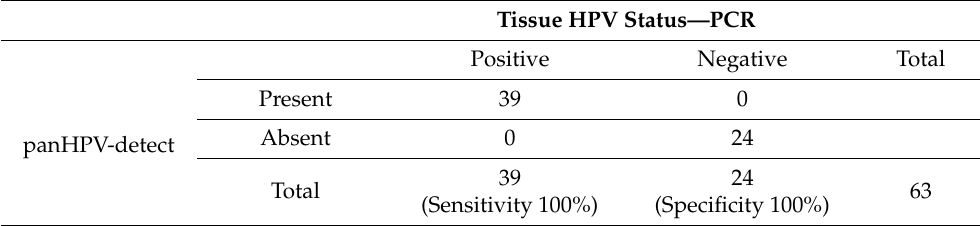
Table 2. Sensitivity and specificity of panHPV-detect assay following initial validation of panHPV- detect in cervical cancer tissue samples obtained from another biobank that were confirmed HPV positive. Refer to text for details on negative controls.